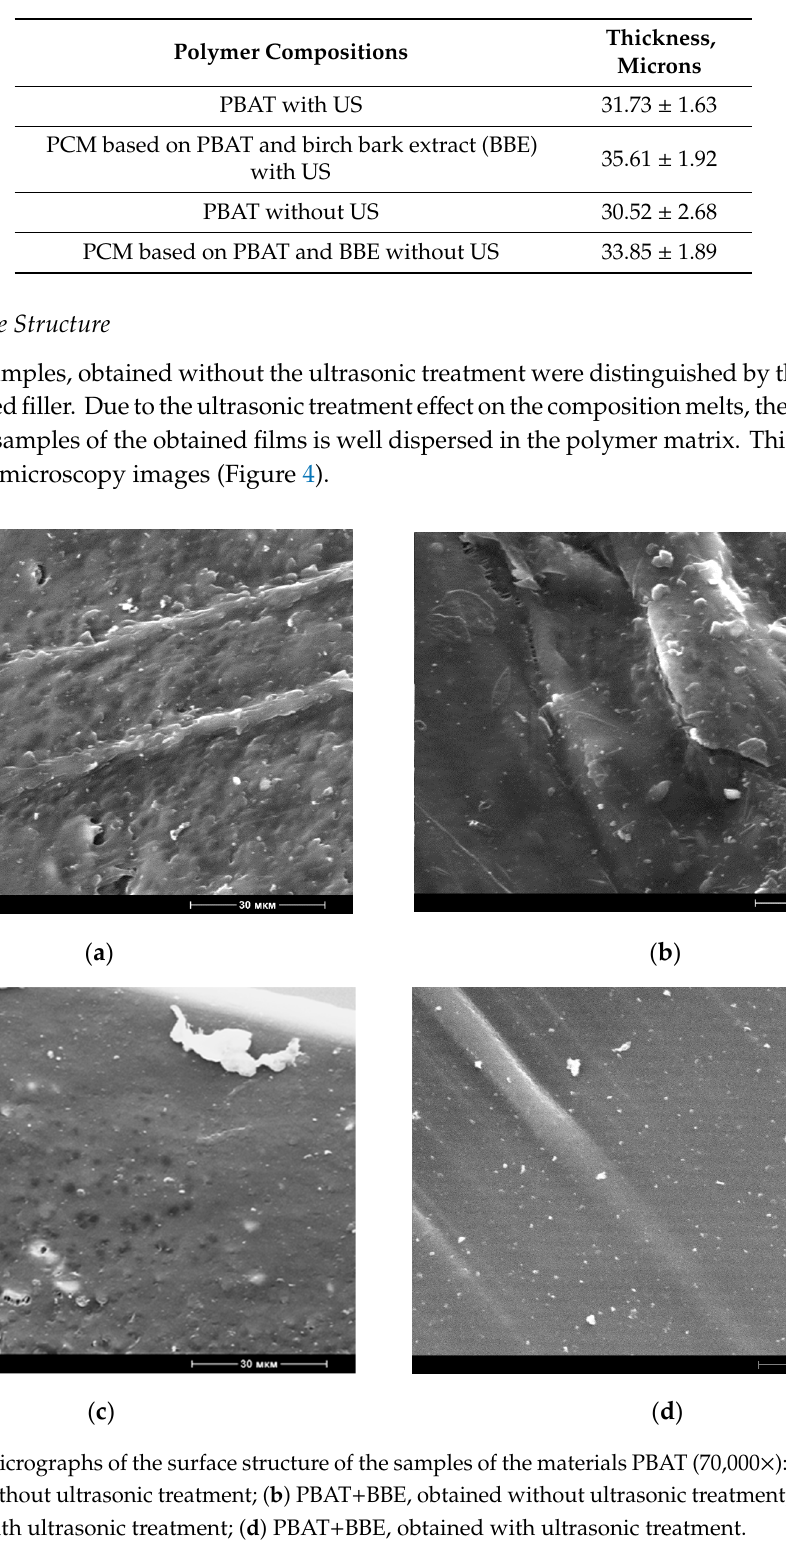
Table 3. Thickness of the obtained PCM film samples.